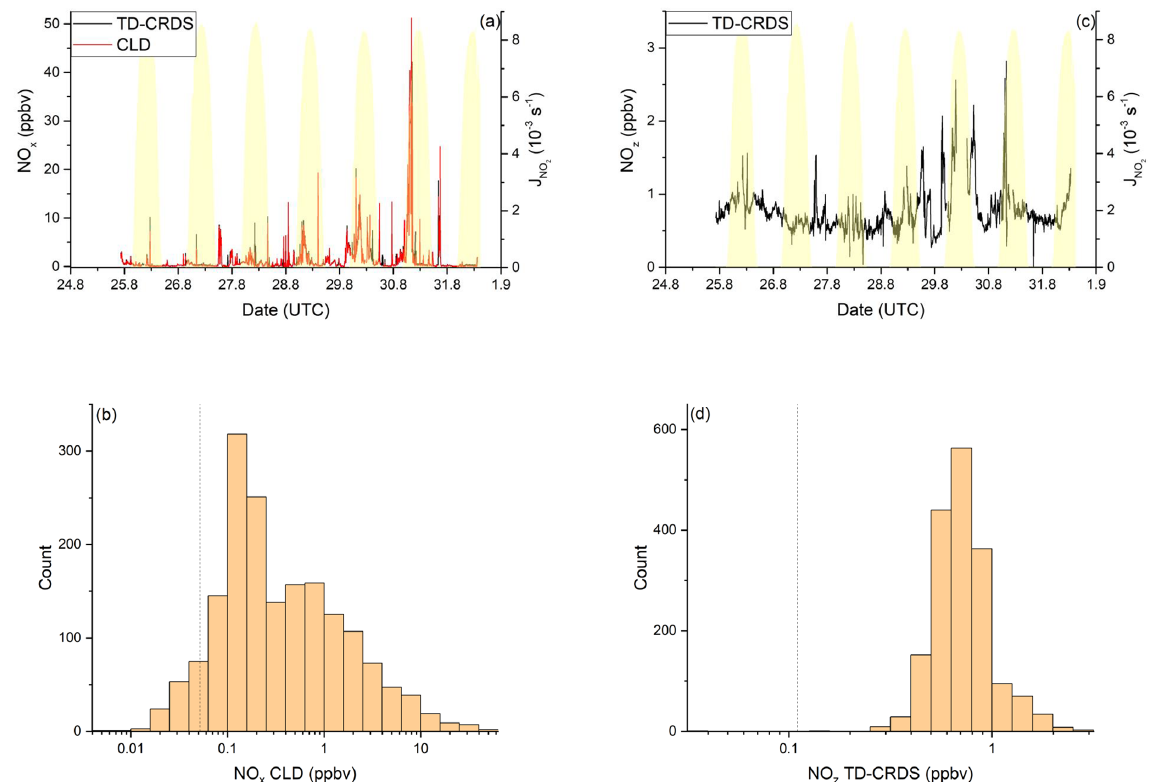
Figure 2. NO y measurements in the Mediterranean Sea . Dashed lines signify the instrument detection limits. (a) NO x mixing ratios by CLD and TD-CRDS. (b) Frequency distribution of NO x mixing ratios between 25 August and 1 September 2017. (c) NO z mixing ratios by TD-CRDS. (d) Frequency distribution of NO z mixing ratios between 25 August and 1 September 2017. The yellow shaded regions show J NO . The vertical dotted lines are the limits of detection of the respective 2